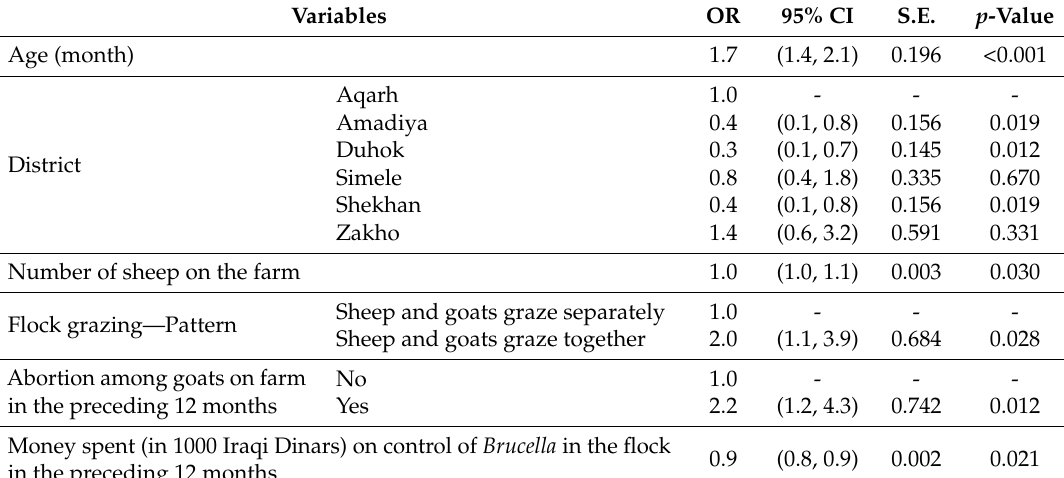
Table 4. Multivariable logistic regression analysis of risk factors associated with brucellosis seropositivity among small ruminants from Duhok Province (Iraq). CI: confidence interval; OR: odds ratio; S.E: standard